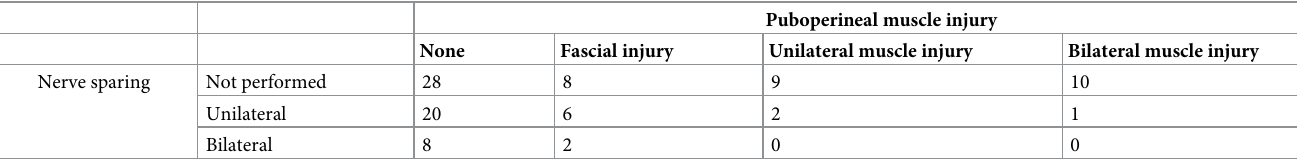
Table 2. Number of patients with puboperineal muscle